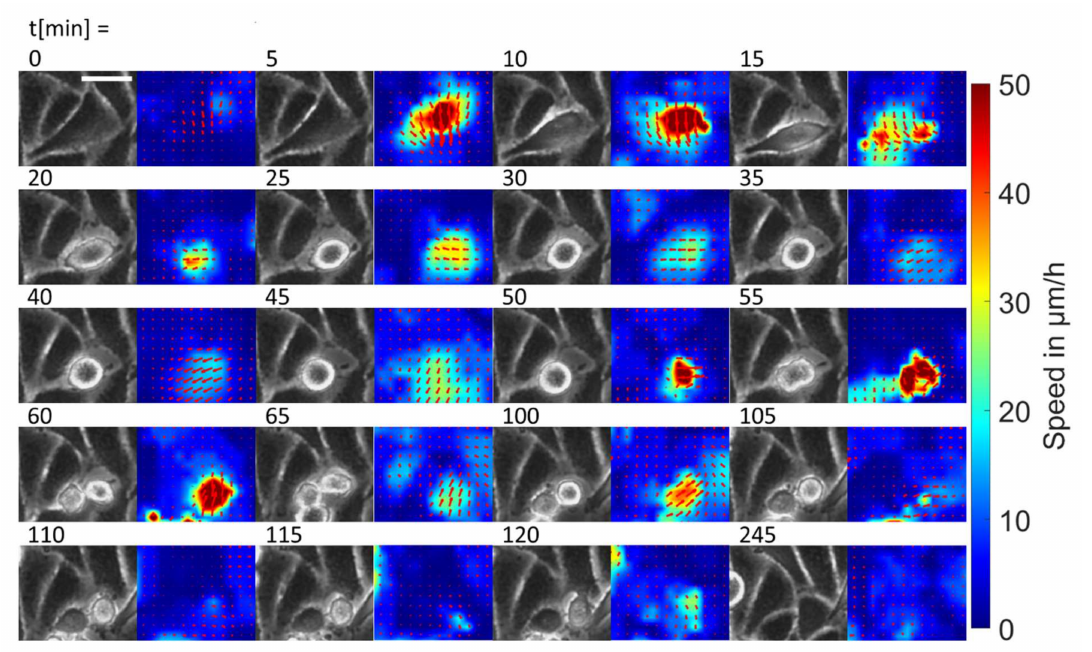
Figure 4. Effects of cell division on local cellular velocities. This image collection depicts a single cell division, together with the associated local speeds as a function of time. Please denote the high speeds during mitotic rounding and subsequent high speeds during the expansion of the two daughter cells. The scale bar depicts 50 µ m.